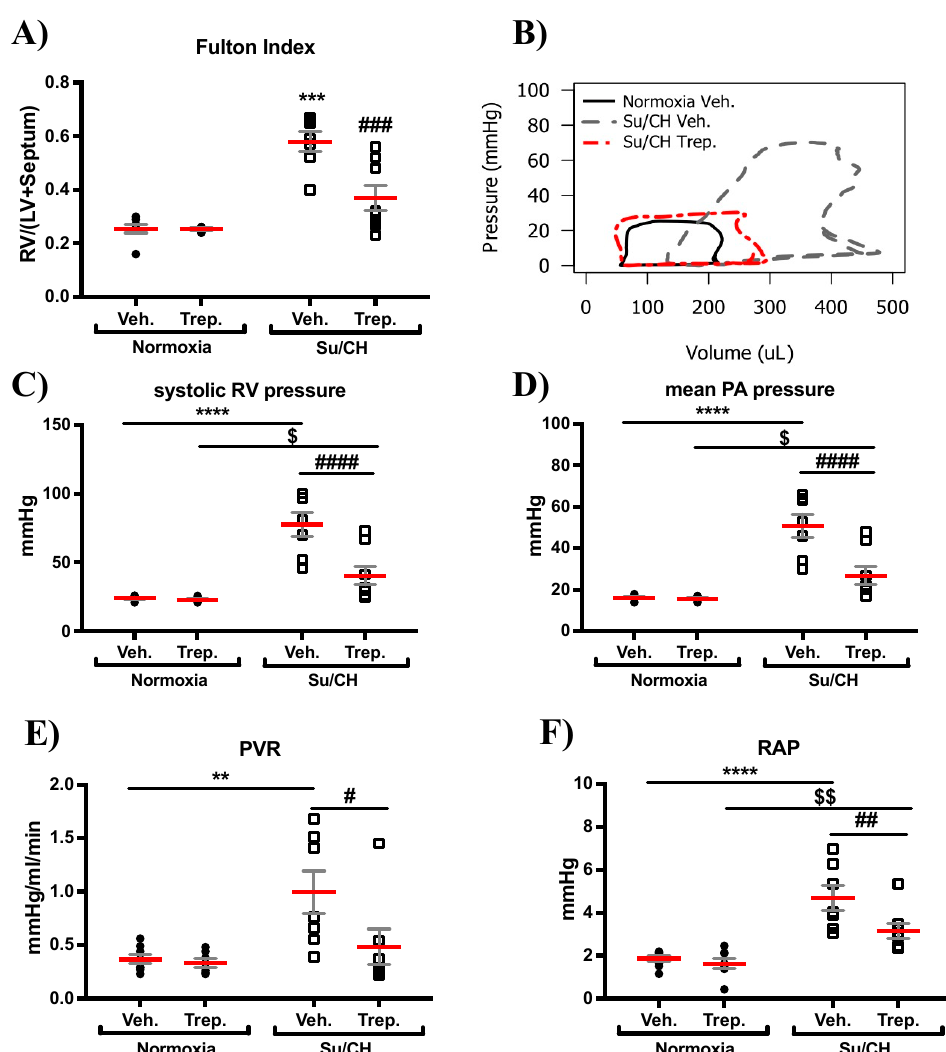
Figure 1. Hemodynamic assessment of PAH induced by Sugen and chronic hypoxia (SuCH). In- dividual value plots for ( A ) Fulton Index. ( B ) representative pressure–volume loops for normoxia vehicle (normoxia+Veh.; black line), SuCH Vehicle (SuCH+Veh.; dotted gray line), and SuCH tre- prostinil (SuCH+Trep.; dotted red line). ( C – F ) grouped individual value plots for ( C ) RV pressure, ( D ) mean pulmonary artery (PA) pressure, ( E ) pulmonary vascular resistance (PVR), and ( F ) right atrial pressure (RAP); n = 7–8 animals/experimental group; *, $, and # present significance vs. normoxia+Veh., normoxia+Trep., and SuCH+Veh., respectively; $ and # p ≤ 0.05; **, $$, and ## p ≤ 0.01; *** and ### p ≤ 0.001; **** and #### p ≤ 0.0001.